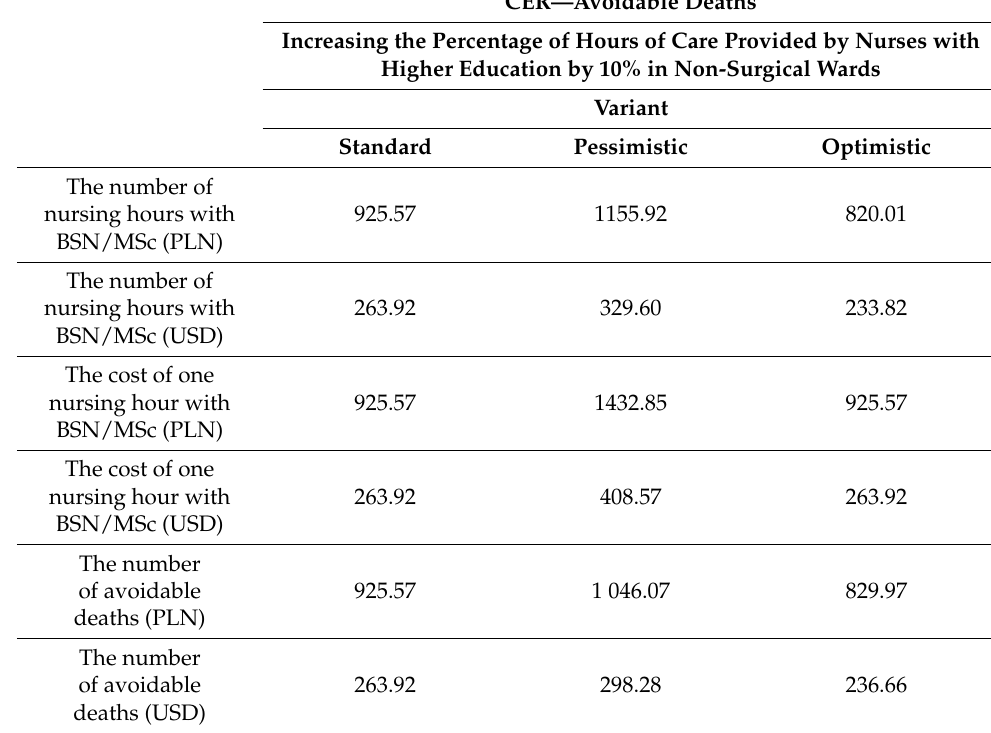
Table 5. Sensitivity